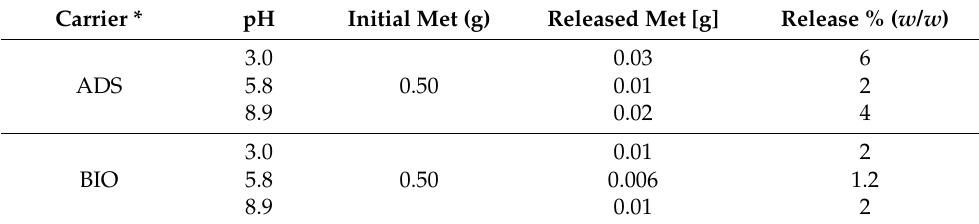
Table 1. Released methionine at different pH from two different carriers (Adsorbene and BioKi). Tests were performed on 2 g of Met-carrier, which correspond to 0.5 g of total initial methionine in the analysed sample.